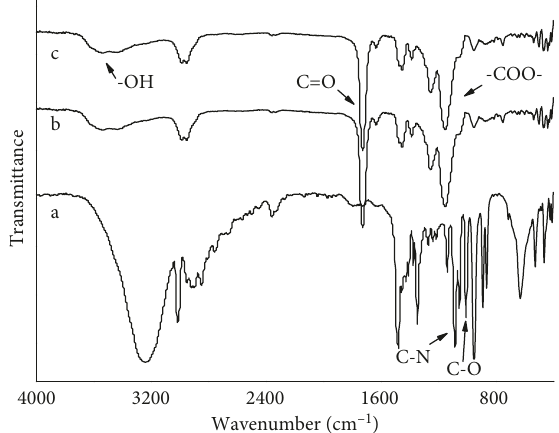
Figure 2: FT-IR spectra of choline chloride (ChCl) (a), DESs-NIPs (b), and DESs-MIPs (c). Table 2: The pore data and surface areas obtained from the DESs-